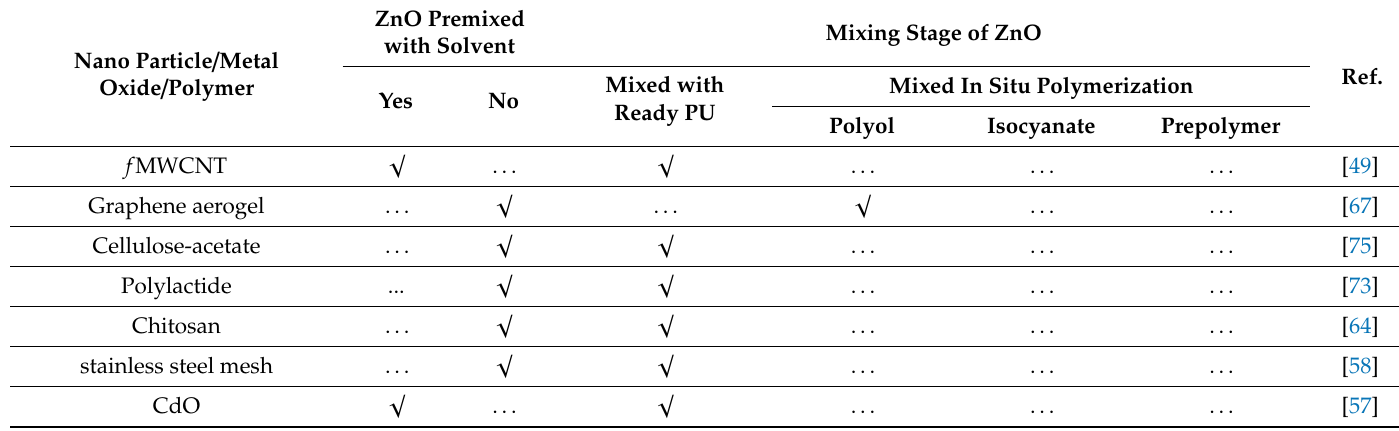
Table 3. Mixing of pristine ZnO along with other nano particle / metal oxide / polymer during PU / ZnO dispersion